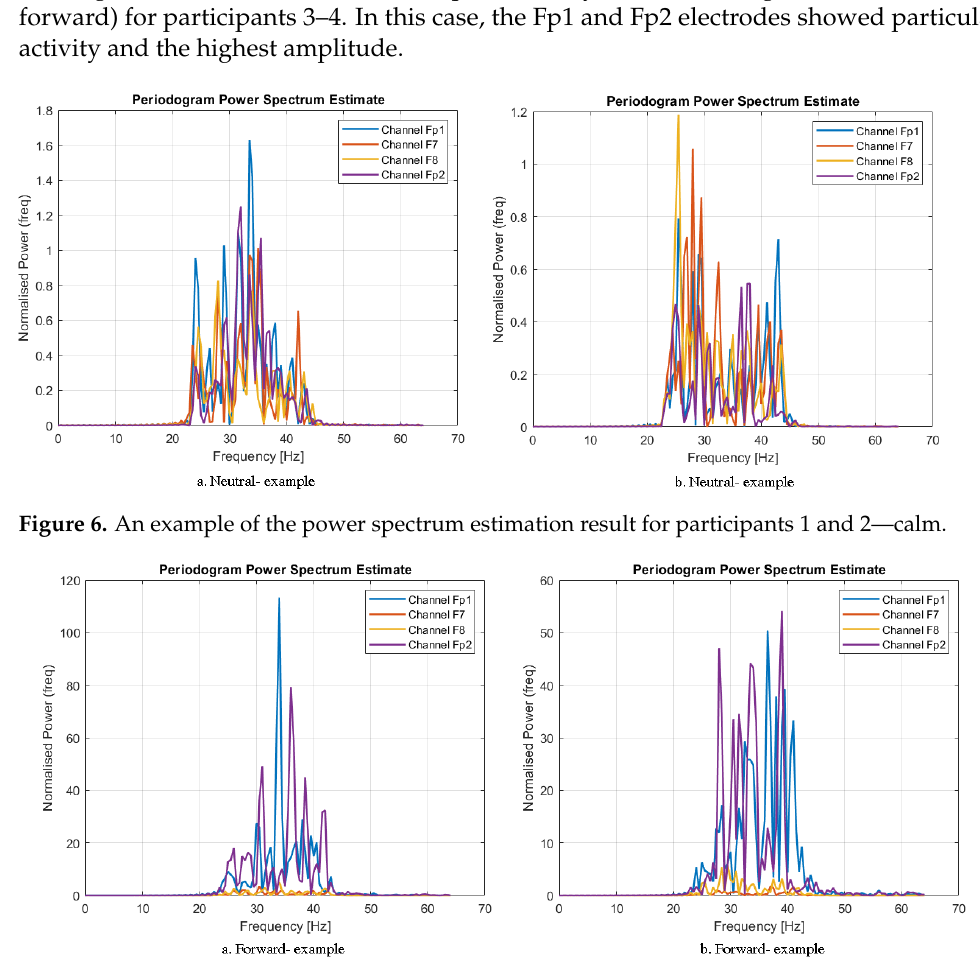
Figure 7. An example of the power spectrum estimation result for participants 3 and 4—forward.